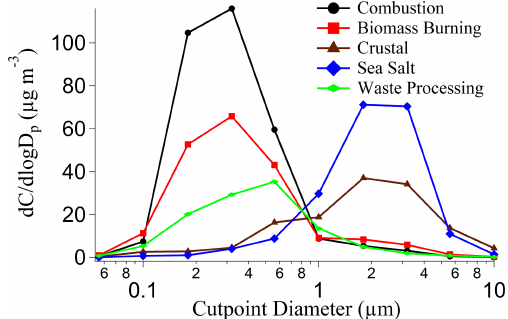
Figure 5. Reconstructed mass size distributions of positive matrix factorization (PMF)